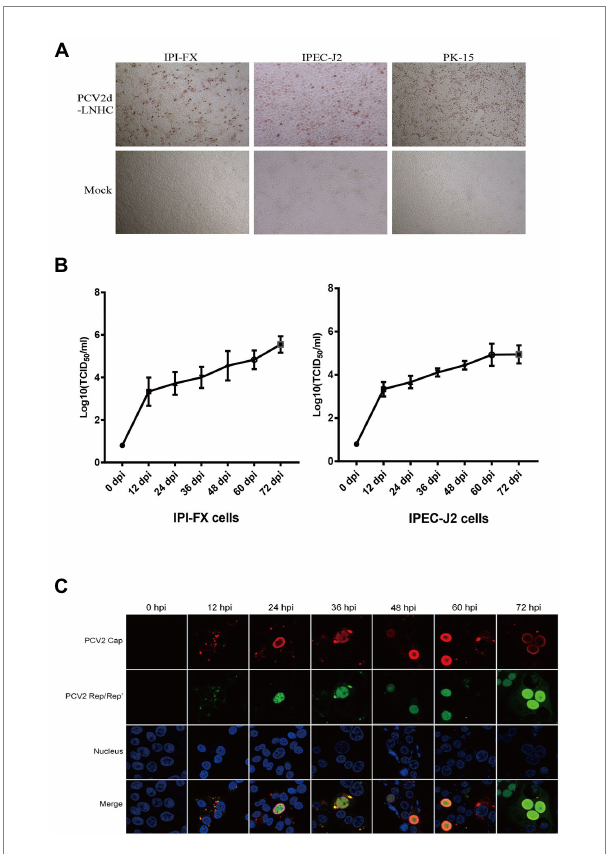
FIGURE 2 PCV2 replicates in IPI-FX and IPEC-J2 cells. IPI-FX and IPEC-J2 cells were inoculated with PCV2d-LNHC (MOI = 2). After culture for 72 h, the cells were fixed and stained with an IPMA (A) . IPI-FX and IPEC-J2 cells were inoculated with PCV2d-LNHC (MOI = 5) and then harvested and freeze–thawed at the indicated times to obtain viral stocks and the viral titers were determined. Growth curves were plotted with the viral titers thus determined (B) . IPI-FX cells were inoculated with PCV2d-LNHC. The cells were then fixed and stained with antibodies at the indicated time points, and immunofluorescence was observed with laser confocal microscopy (C)